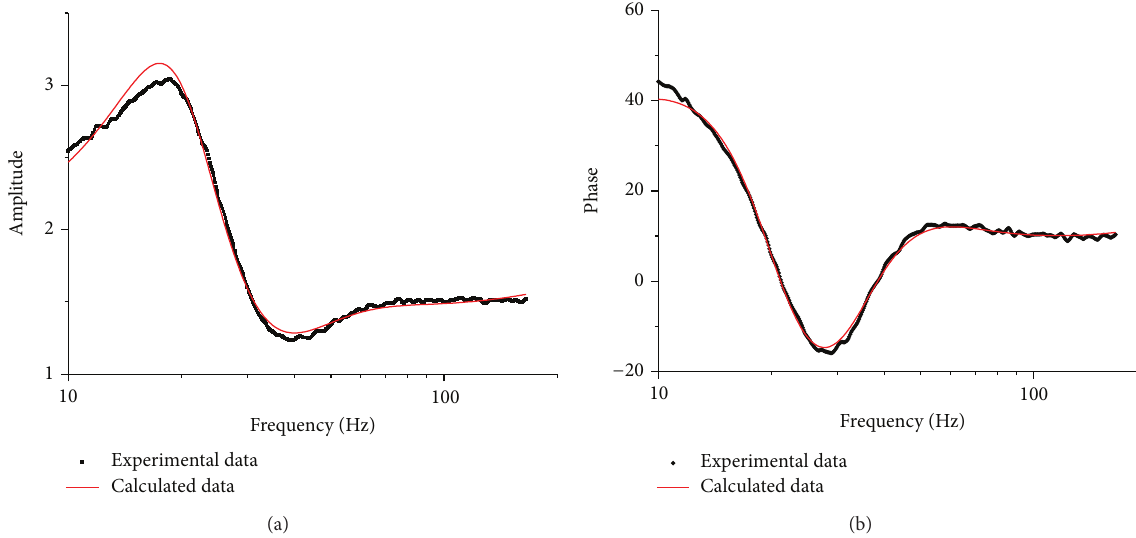
Figure 12: Experimental (points) and theoretically calculated (full line) PA amplitude (a) and phase difference (b) spectra of PbTe doped with 1.7 at%